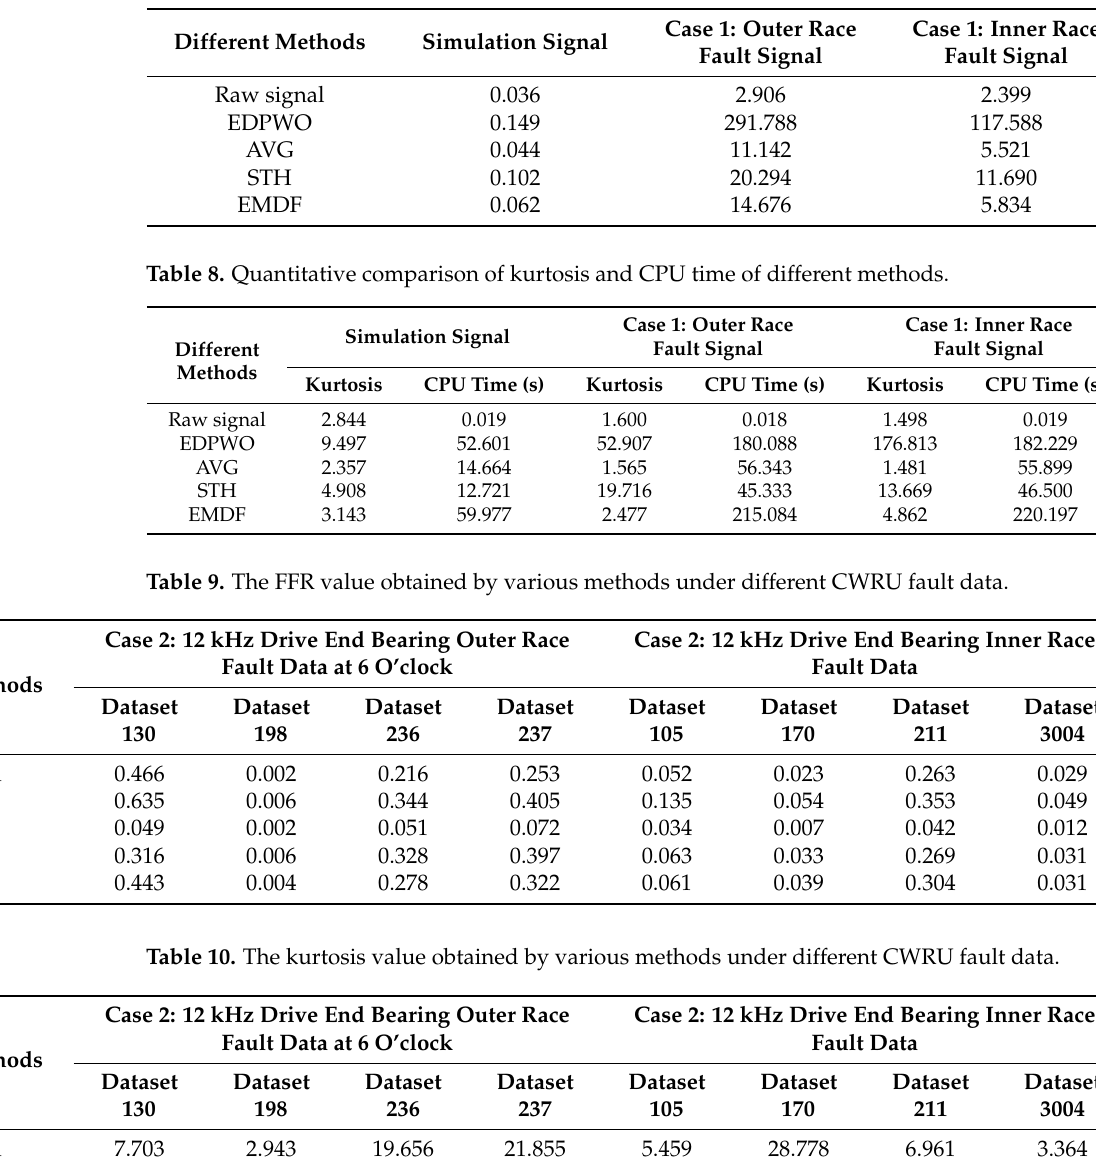
Table 7. Quantitative comparison of FFR of different methods.